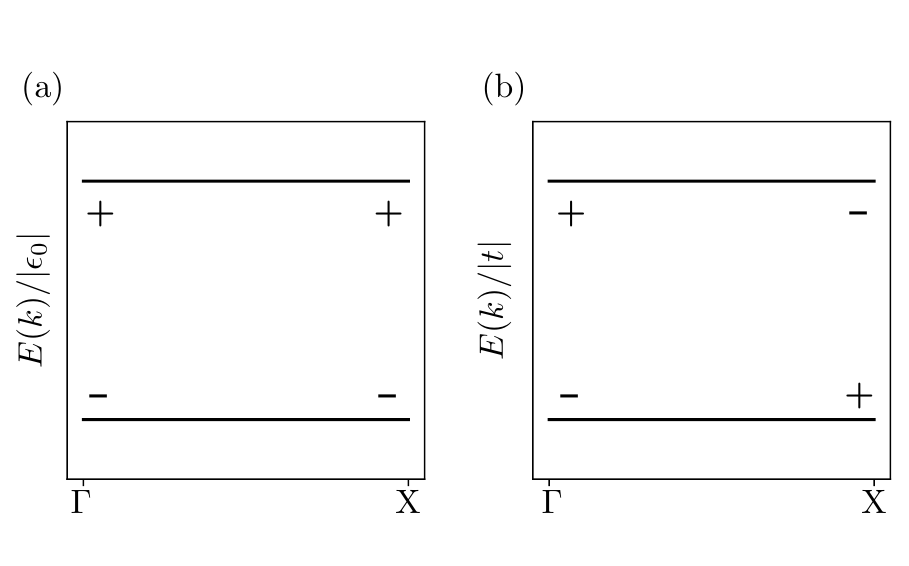
Figure 6: Flat bands of the Rice-Mele Hamiltonian in the two limits discussed in the text, with the inversion eigenvalues at Γ and X labeled